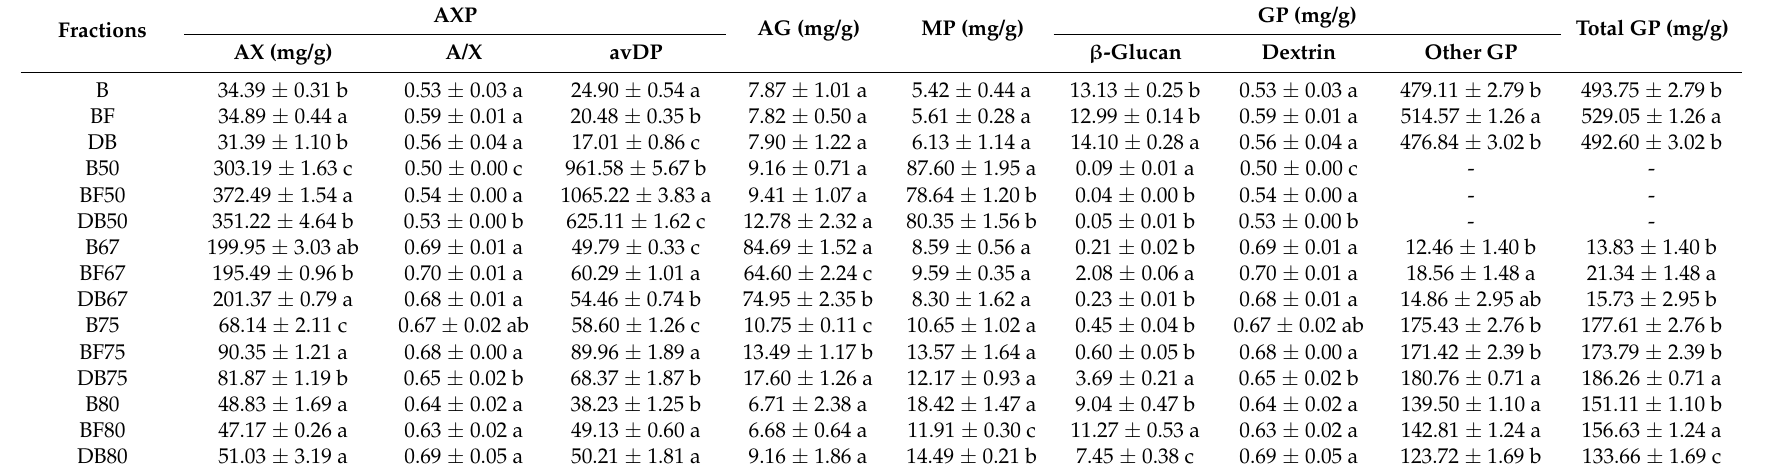
Table 3. Analysis of polysaccharides in wheat beer, beer foam, and defoamed